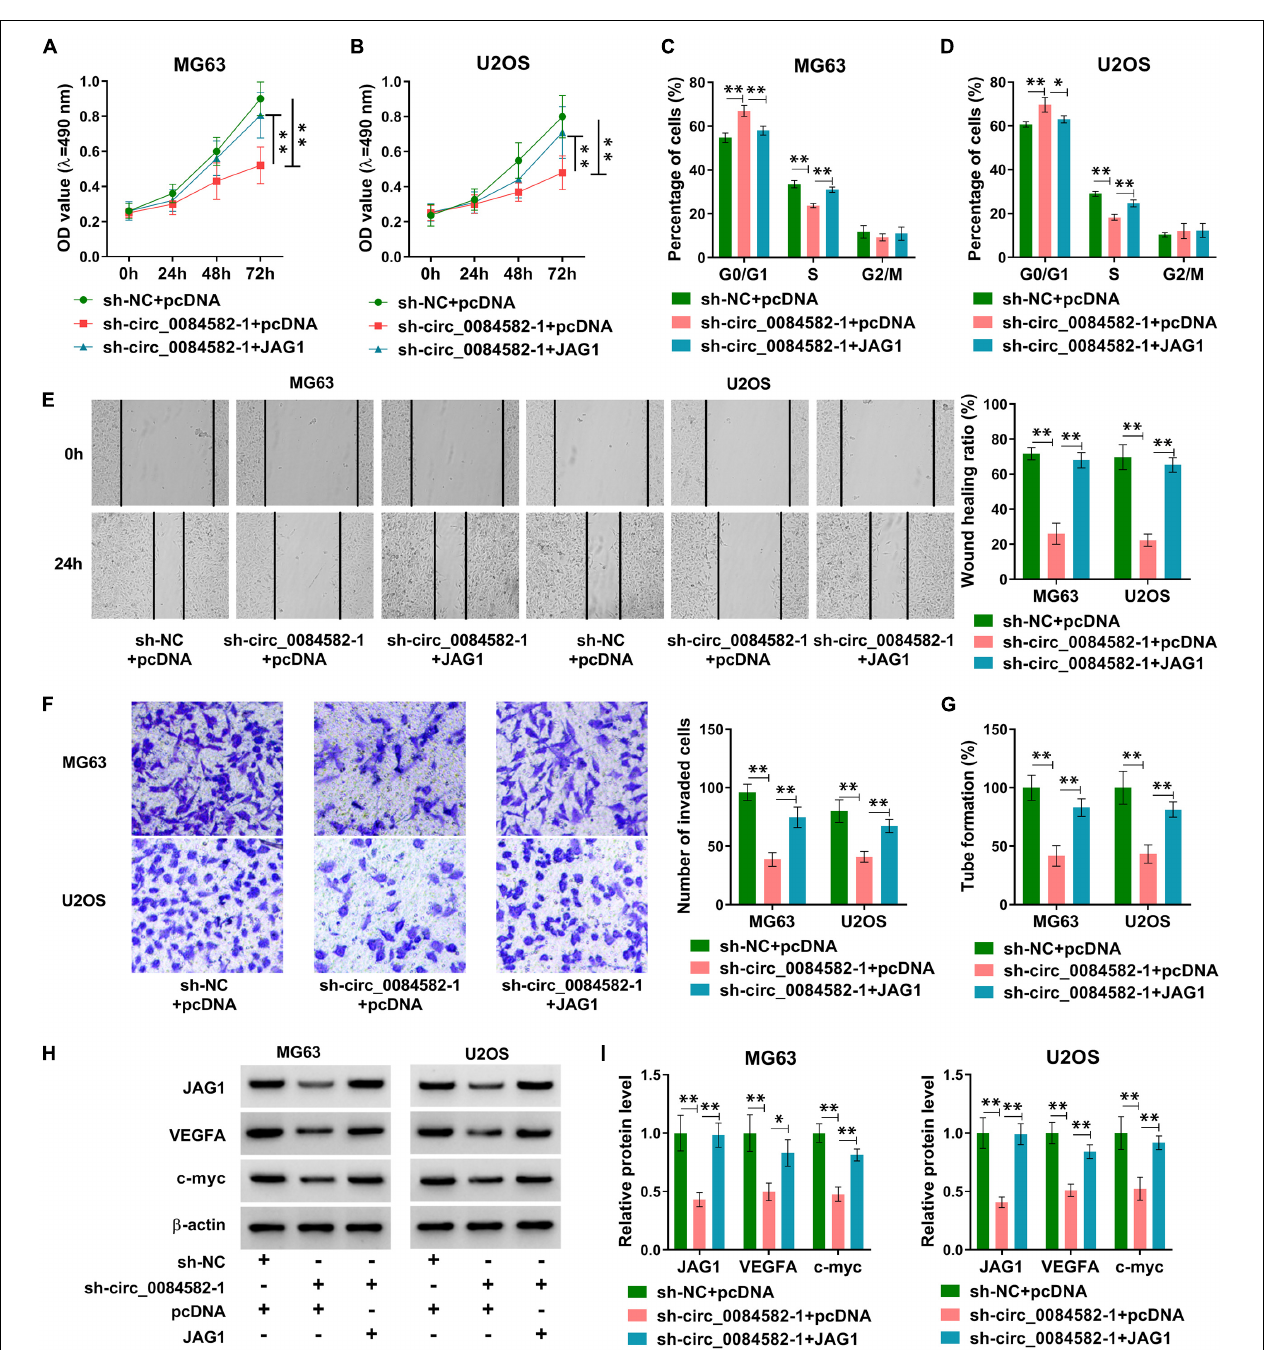
FIGURE 4 | JAG1 overexpression reverses the effects of circ_0084582 knockdown on OS cells. (A,B) Cell proliferation was determined by MTT assay after transfection of sh-NC + pcDNA, sh-circ_0084582-1 + pcDNA, or sh-circ_0084582-1 + JAG1. (C,D) Cell cycle progression was analyzed by flow cytometry. (E,F) Cell migration and invasion were, respectively, measured using wound-healing and transwell assays. (G) Angiopoiesis was detected by a tube formation assay. (H,I) JAG1, VEGFA, and c-myc protein levels were examined by Western blot. All experiments were performed with three biological replications. ∗ P < 0.05, ∗∗ P <